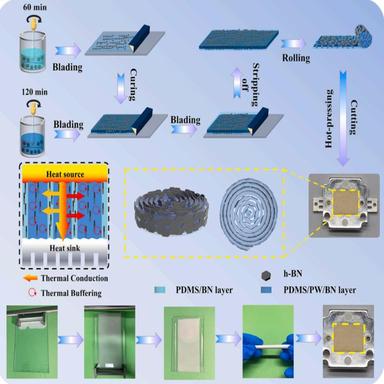
Schematic illustrations of the fabrication process for PDMS/PW/BN PCMs.